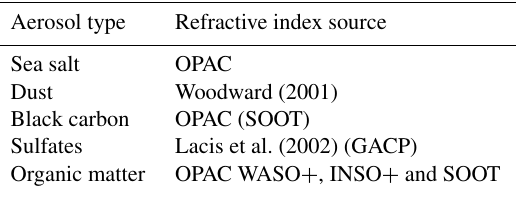
Table 11. Refractive index and parameters of the size distribution associated with each aerosol type in IFS-AER. The organic matter type is represented by a mixture of three OPAC types similar to the average continental mixture, as described in Hess et al.